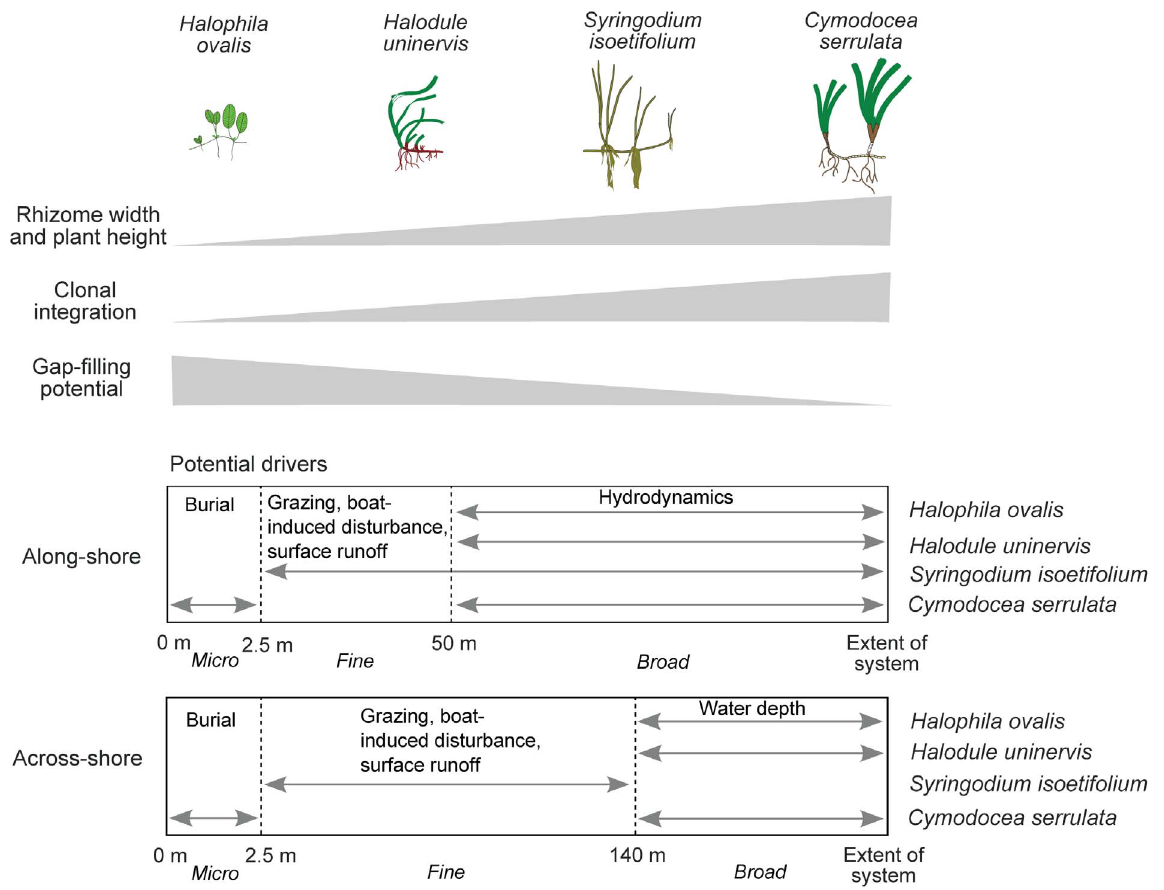
Figure 6. Relative characteristics of the four seagrass species in Pulau Tinggi, Malaysia, including rhizome width and plant height (species size), degree of clonal integration and gap-filling potential. Potential drivers in the along-shore and across-shore are shown. Arrows denote the distances at which a species is most strongly influenced ( . 30% variance in the Linear Model of Coregionalization).